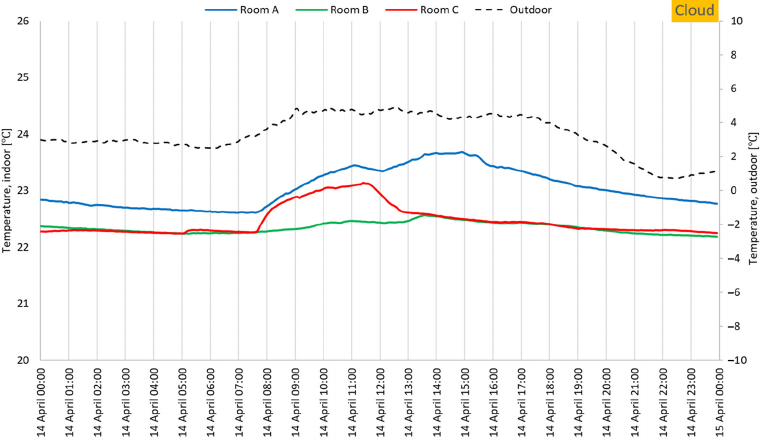
Figure 20. Comparison of temperature outdoors and indoors in all three rooms for 1 day when it was cloudy outside. The indoor temperature of the three rooms is shown on the left axis, and the outdoor temperature is shown on the right